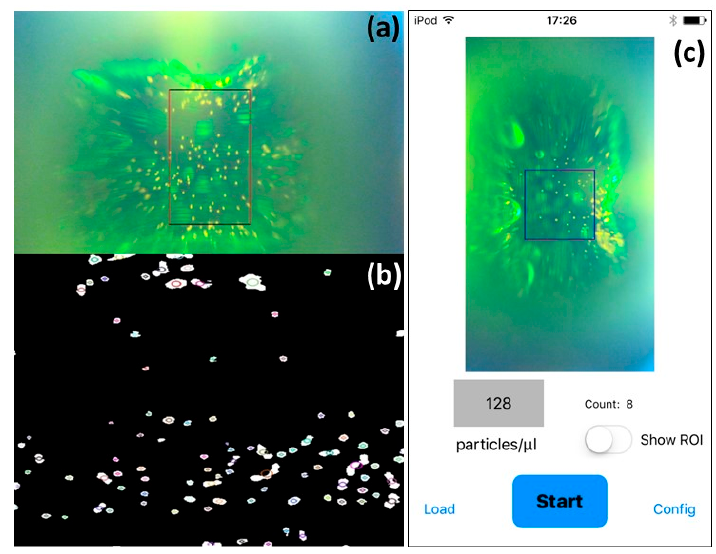
Figure 7. ( a ) Single frame of one video captured with the flow cytometry platform and ( b ) selected ROI with the identification of the flowing particles (circles around white spots); ( c ) Software application screenshot; the particle concentration is given at the end of the measurement.